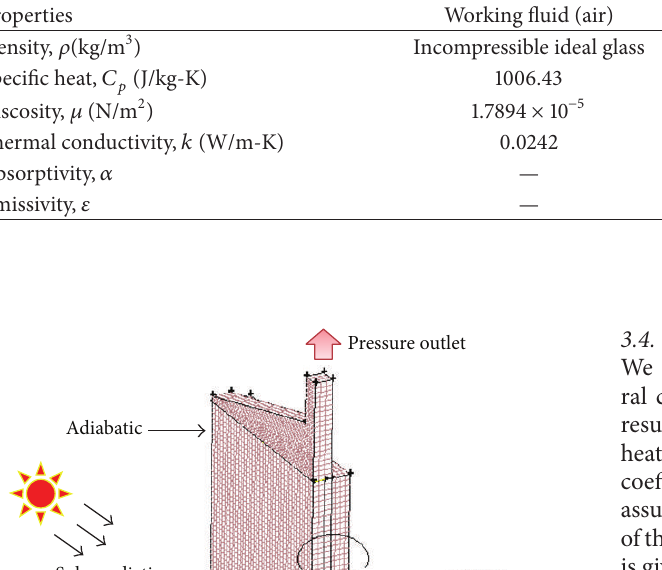
Table 1: Thermophysical properties of working fluid (air) and absorber plate (aluminum) for computational analysis.